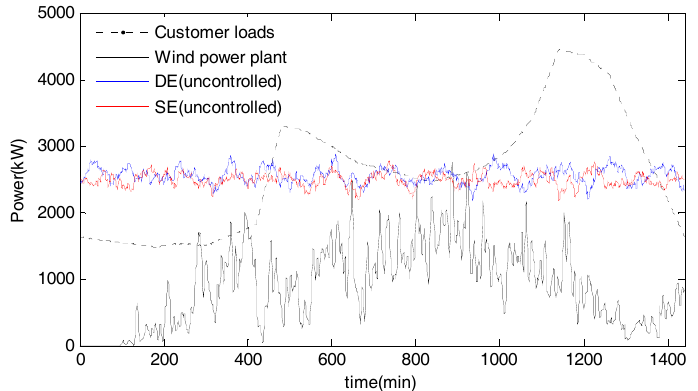
Figure 6. Uncontrolled customer loads and electrolyzer loads on the supply and demand side with wind energy integration (Case-1).